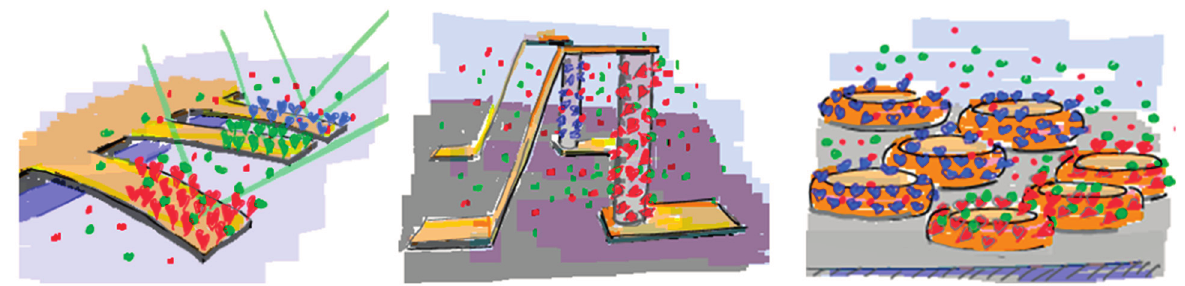
Figure 1. Schematic illustration of ( left ) small-scale surface-stress sensitive cantilevers, ( middle ) semiconductor nanowires and ( right ) nanoplasmonically active gold discs designed with immobilized probe molecules for selective detection of suspended analyte molecules. The different colors represent capture agents for different molecules immobilized on the respective